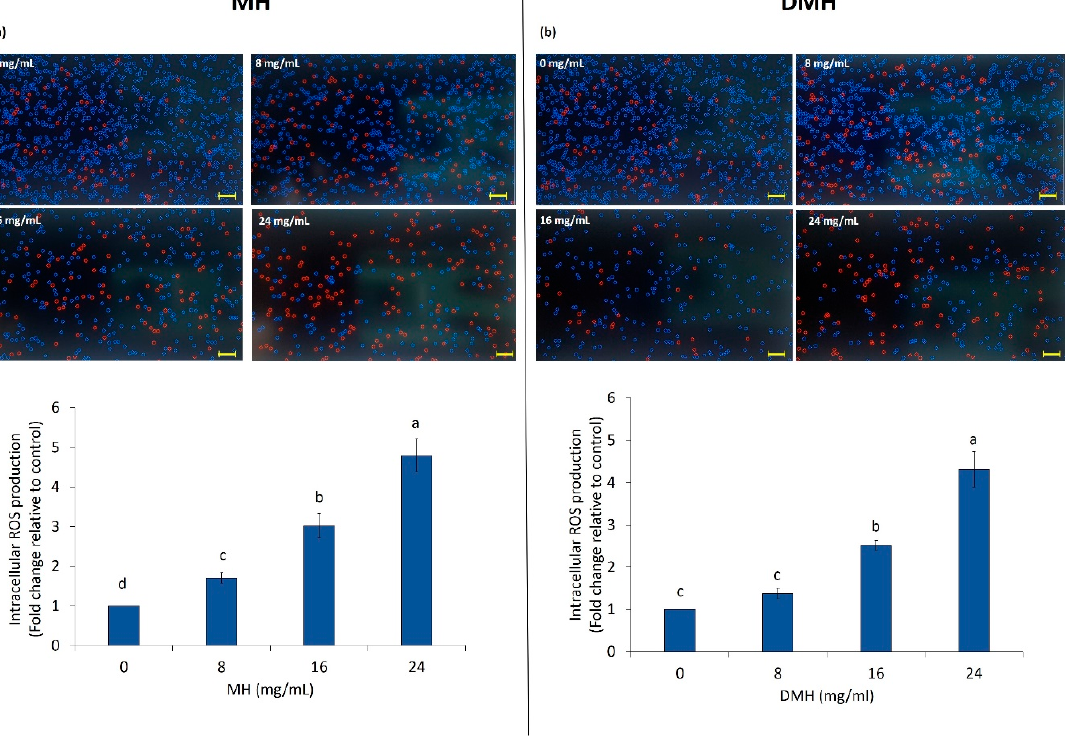
Figure 4. MH ( a ) and DMH ( b ) induce ROS production in HCT-116 cells. The cells were treated with different concentrations (0, 8, 16 and 24 mg/mL) of MH or DMH for 48 h. Intracellular ROS accumulation in HCT-116 was determined by CellROX ® Orange assay kit with Tali ® Image-Based Cytometer. Values are expressed as the mean of three independent experiment ± SD. The different superscript letters (a–d) in the bars are significantly different ( p < 0.05). The images are representative of intracellular ROS quantification; red color cells represent ROS-induced cells. Scale bar = 50 μ m.